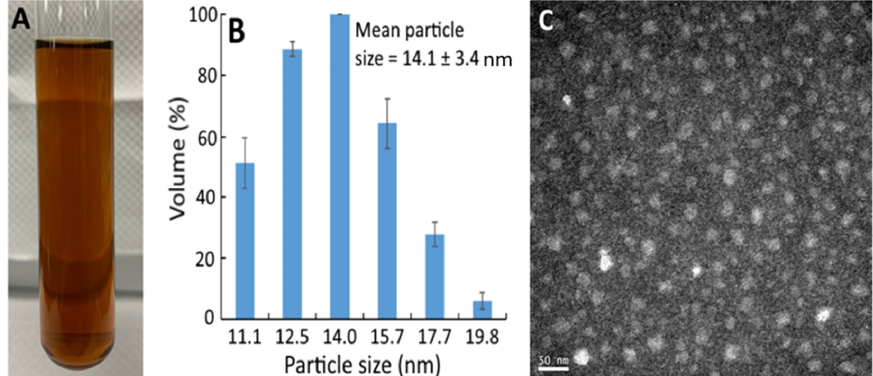
Figure 1. Appearance of resveratrol nanoemulsion prepared from grape skin ( A ) and its particle size distribution as determined by dynamic light scattering method ( B ) as well as the